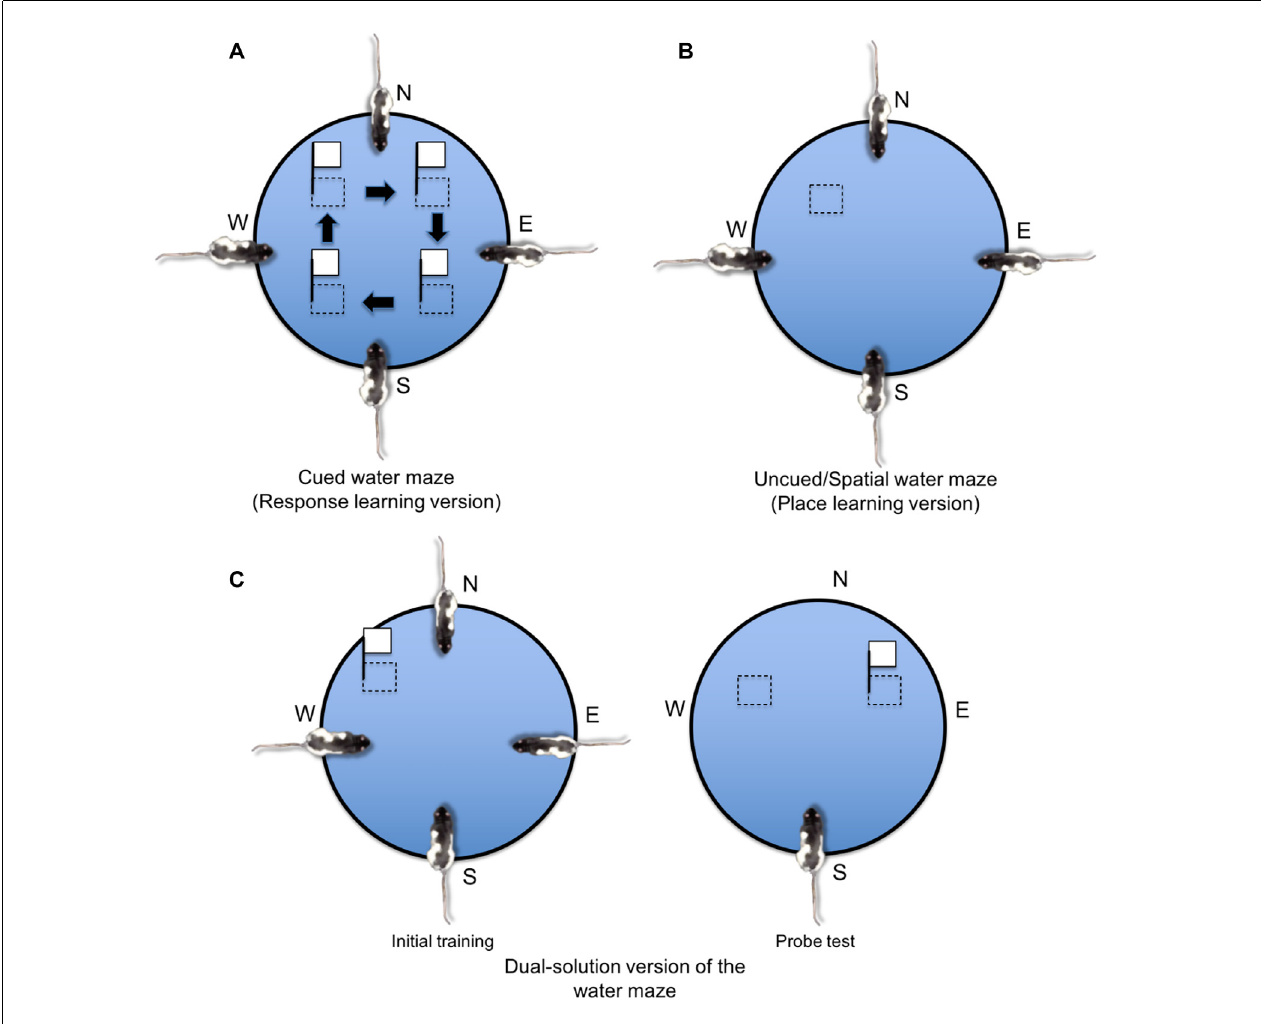
FIGURE 6 | Place and response learning in the water maze. (A) In the cued water maze task, the platform is either visible (i.e., made of a conspicuous opaque material and/or is located above the water surface) or is cued with a proximal object (e.g., a white flag attached to the platform). Throughout training, the platform is rotated to different quadrants of the maze, and the animal must learn to associate the visible stimulus (S) with swimming approach behavior (R). (B) In the uncued spatial water maze task, the platform remains in a consistent spatial location and is visibly hidden below the water surface (the platform may consist of transparent material or the water may be infused with an opaque dye). Therefore, the rat must use extra-maze spatial cues to learn the location of the hidden platform. (C) In the dual-solution version of the water maze, a visibly cued platform remains in the same spatial location across initial training. During a later probe test, the cue is moved to a different maze quadrant. If the rat continues to swim to the same spatial location, the rat is labeled a place learner. If the rat approaches the visible cue, the rat is labeled a response